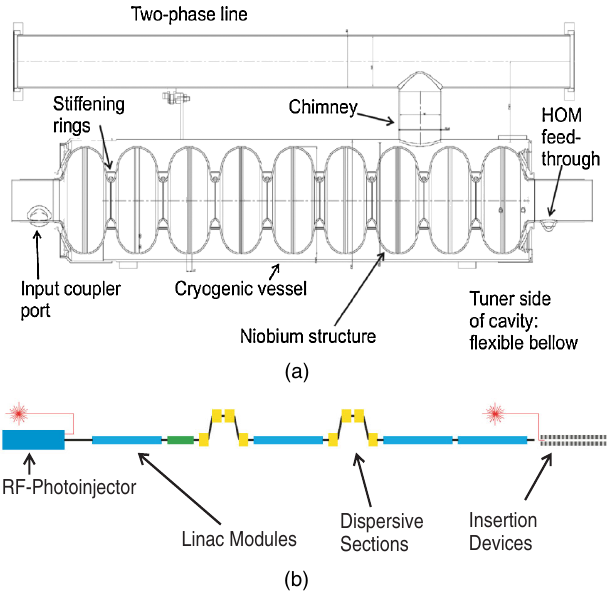
FIG. 1. (Color) (a) Scheme of a TESLA cavity. (b) Generic layout of a linac based FEL.